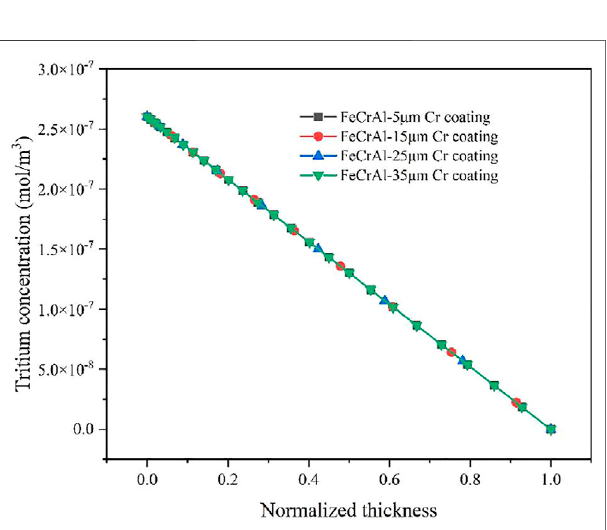
FIGURE 11 | Radial tritium concentration distribution in the FeCrAl cladding with different thickness.